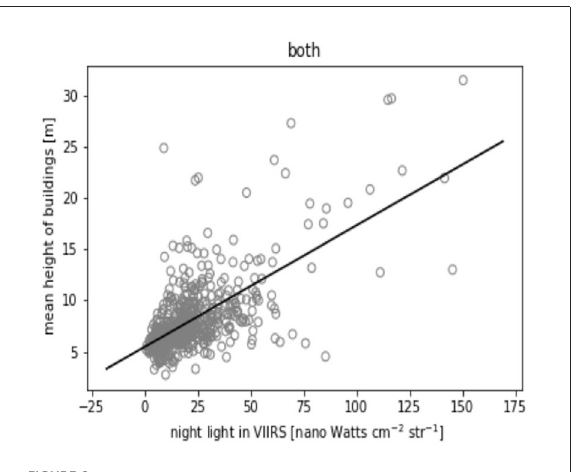
FIGURE6 Scatter plot of the night light and building height for land use ratio between 70 and